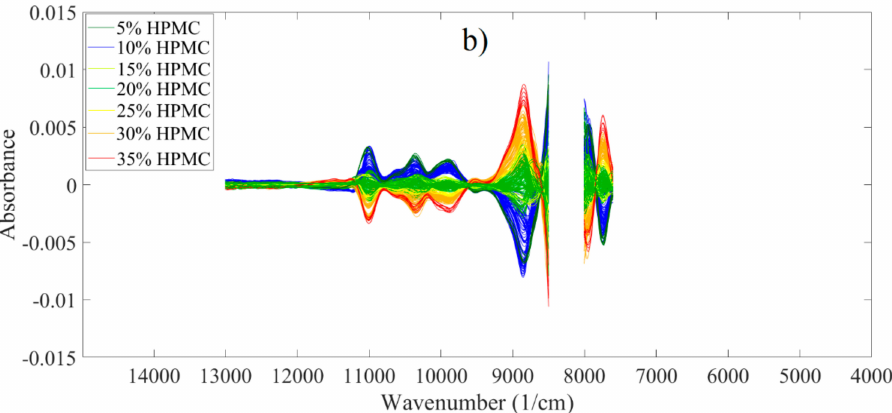
Figure 3. ( a ) Raw near-infrared NIR transmission spectra of training tablets; ( b ) preprocessed spectra.